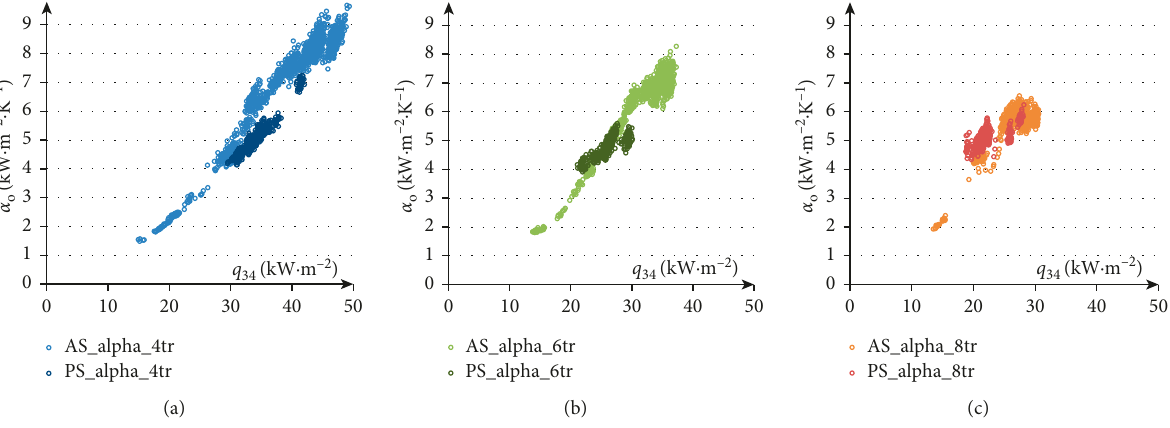
Figure 4: Comparison of heat transfer coefficient in relation to heat input.